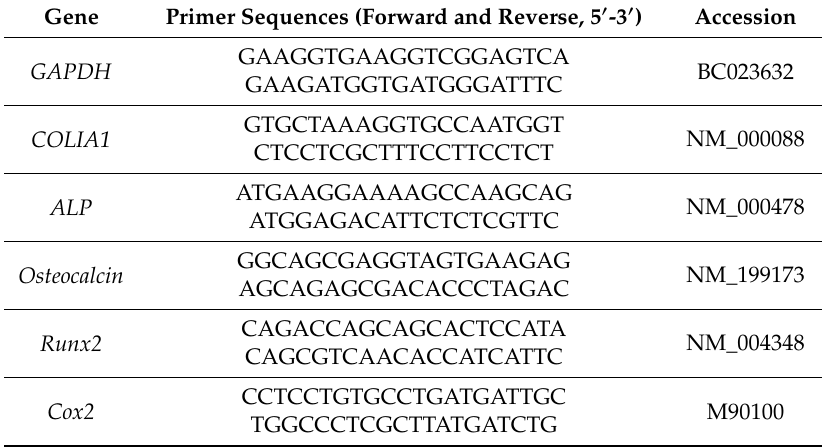
Table 1. Sequence information of primers used for quantitative real-time PCR.